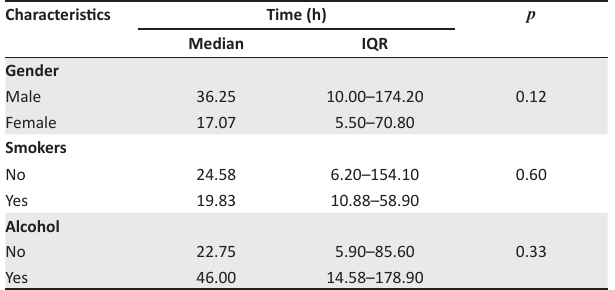
FIGURE 4: Distribution of presenting times to arrival at computed tomography for stroke patients. TABLE 2: Comparison of times to emergency department presentation by